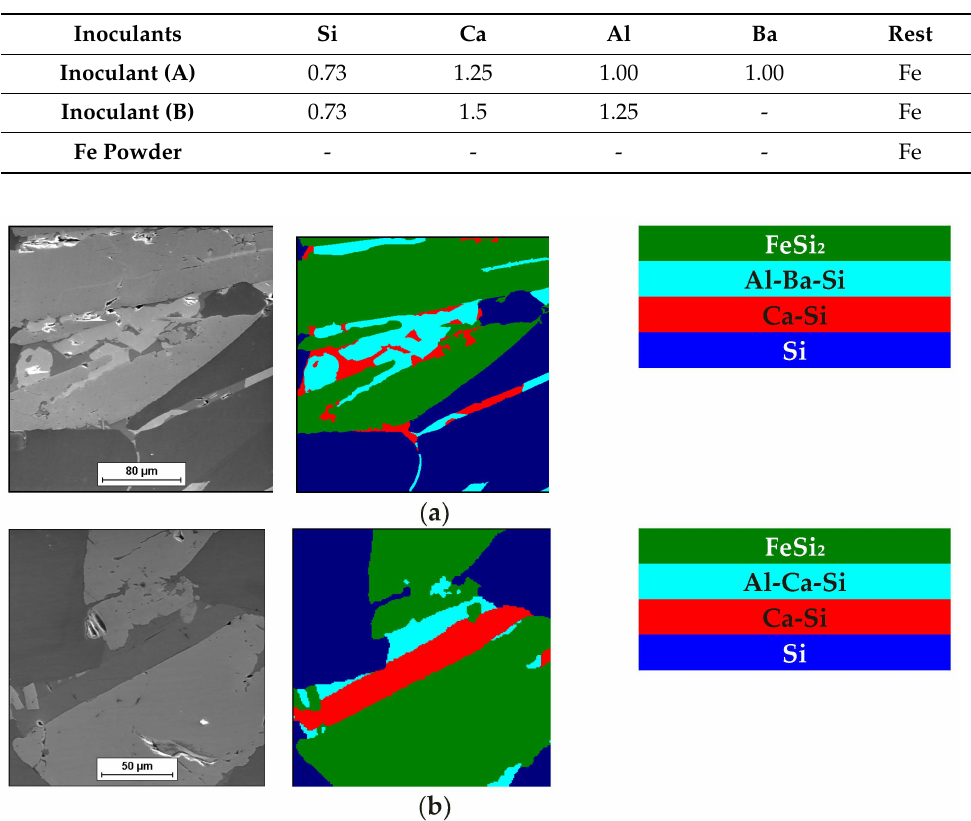
Table 3. Chemical compositions of inoculants (% mass).